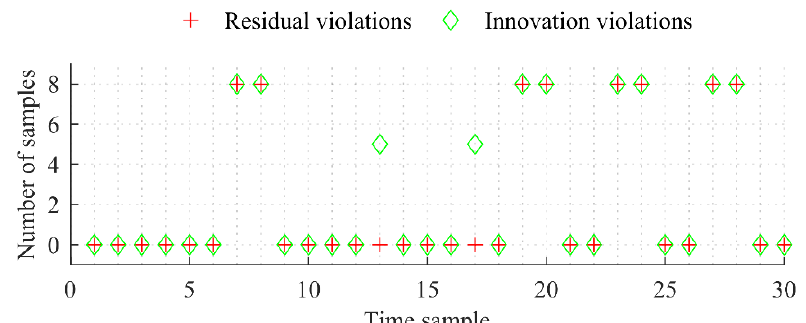
Figure 8. Robust LVSE measurement error flags — case 3.